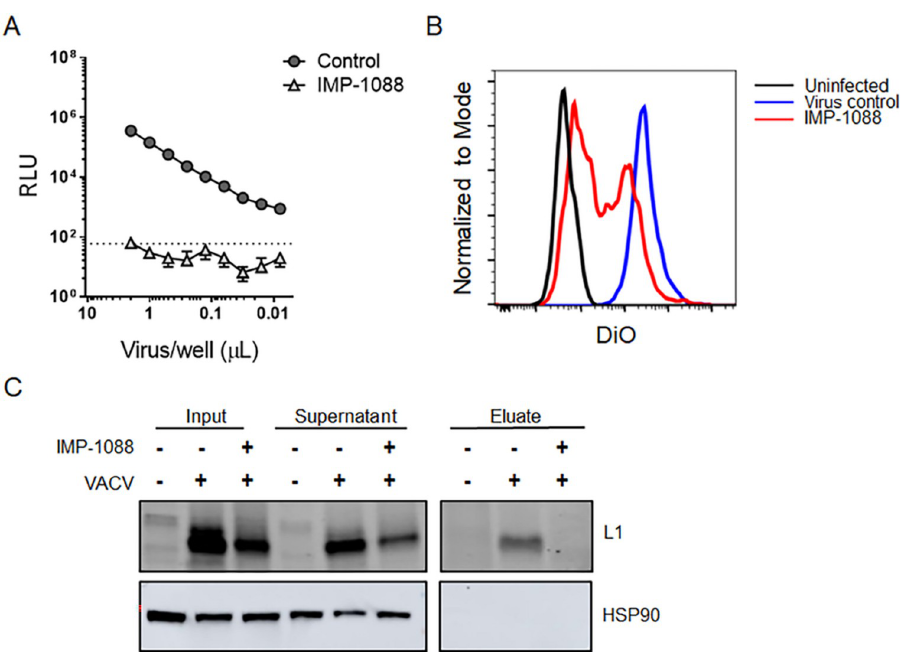
Fig 6. Decrease in VACV infectivity linked to defect in viral entry. (A) IMP-1088 treated virus exhibits lower early gene expression compared to control virus. BSC-40 cells were infected with VACV propagated in the absence or presence of 2 μ M IMP-1088, and luciferase levels were determined 2 hpi as a surrogate of early protein synthesis. Dotted line indicates level of detection. (B) Lower membrane fusion between cells and IMP-1088 treated virus compared to control virus. Virus grown in the presence or absence of IMP-1088 was purified and labelled with fluorescent dye DiO (same virus as Fig 4). Cells were infected with DiO-labeled virus at RT (to determine background signal) and at 37˚C. Transfer of fluorescent dye from viral membrane to cellular membrane was measured by flow cytometry. (C) Western blot to confirm pulldown of L1 protein after metabolic labelling with YnMyr, chemical modification and precipitation using streptavidin resin. The input, supernatant and eluted fractions from uninfected and infected cells in the presence and absence of IMP-1088 were tested for presence of L1 using anti-L1 polyclonal antibody